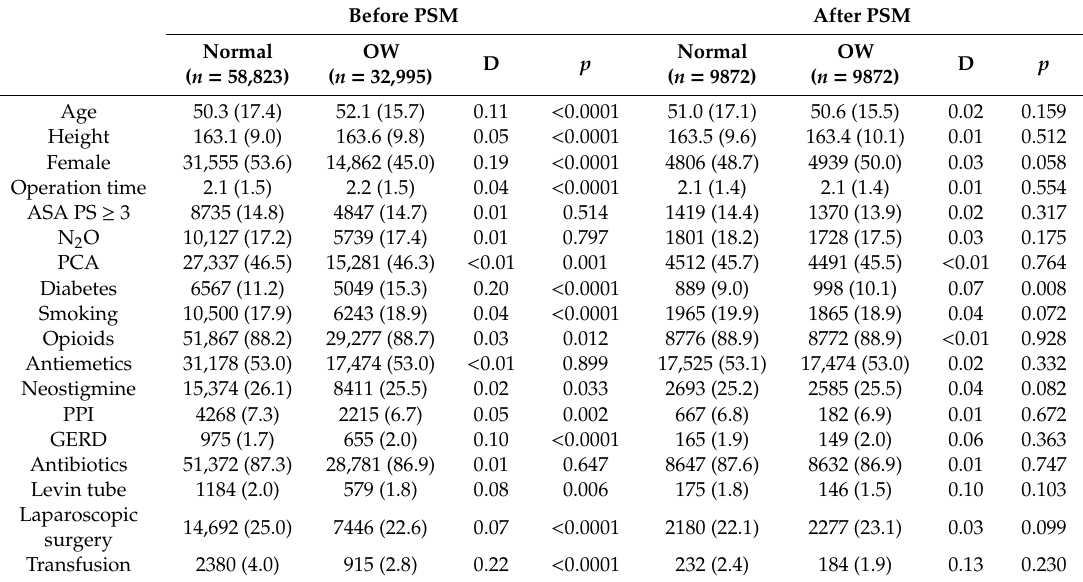
Table 4. Baseline characteristics of normal-BMI and overweight subjects, and comparison before and after propensity score matching.